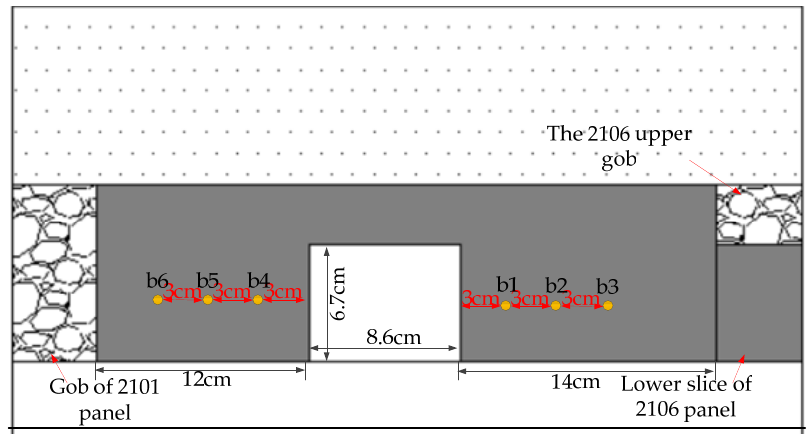
Figure 6. Layout of the earth-pressure cells in the coal pillar.